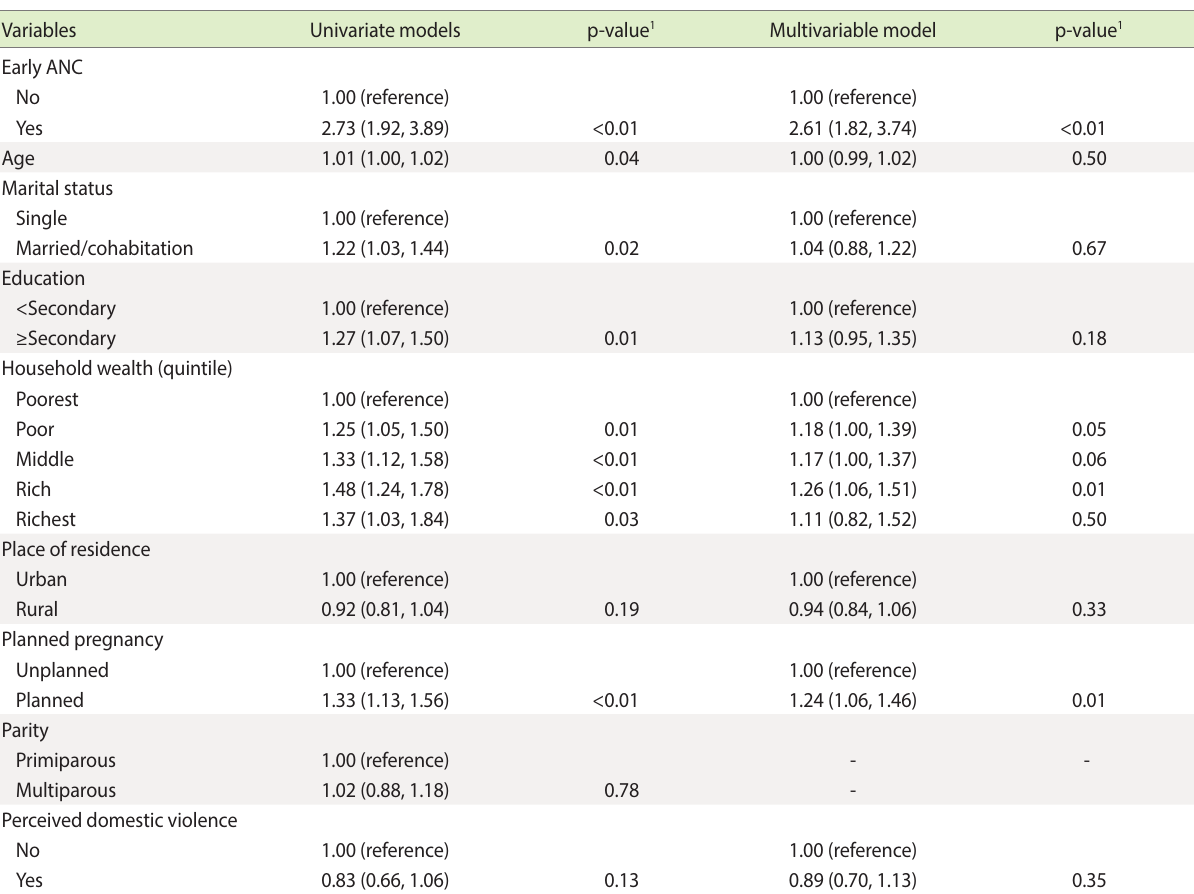
Values are presented as prevalence ratio (95% confidence interval).